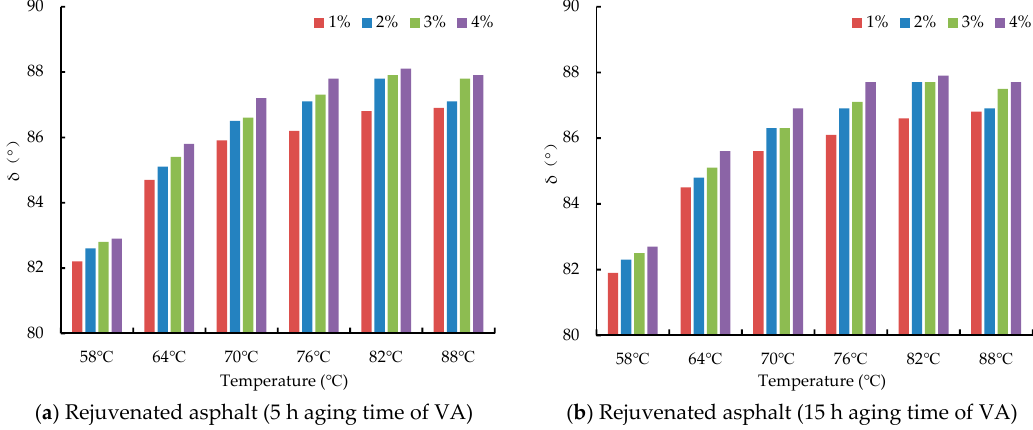
Figure 12. Influences of WCO on phase angel of rejuvenated asphalt (different aging time of VA).